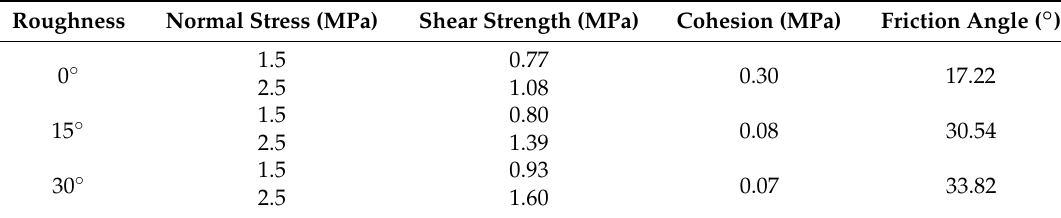
Table 2. Shear strength parameters of joint samples with different roughness.